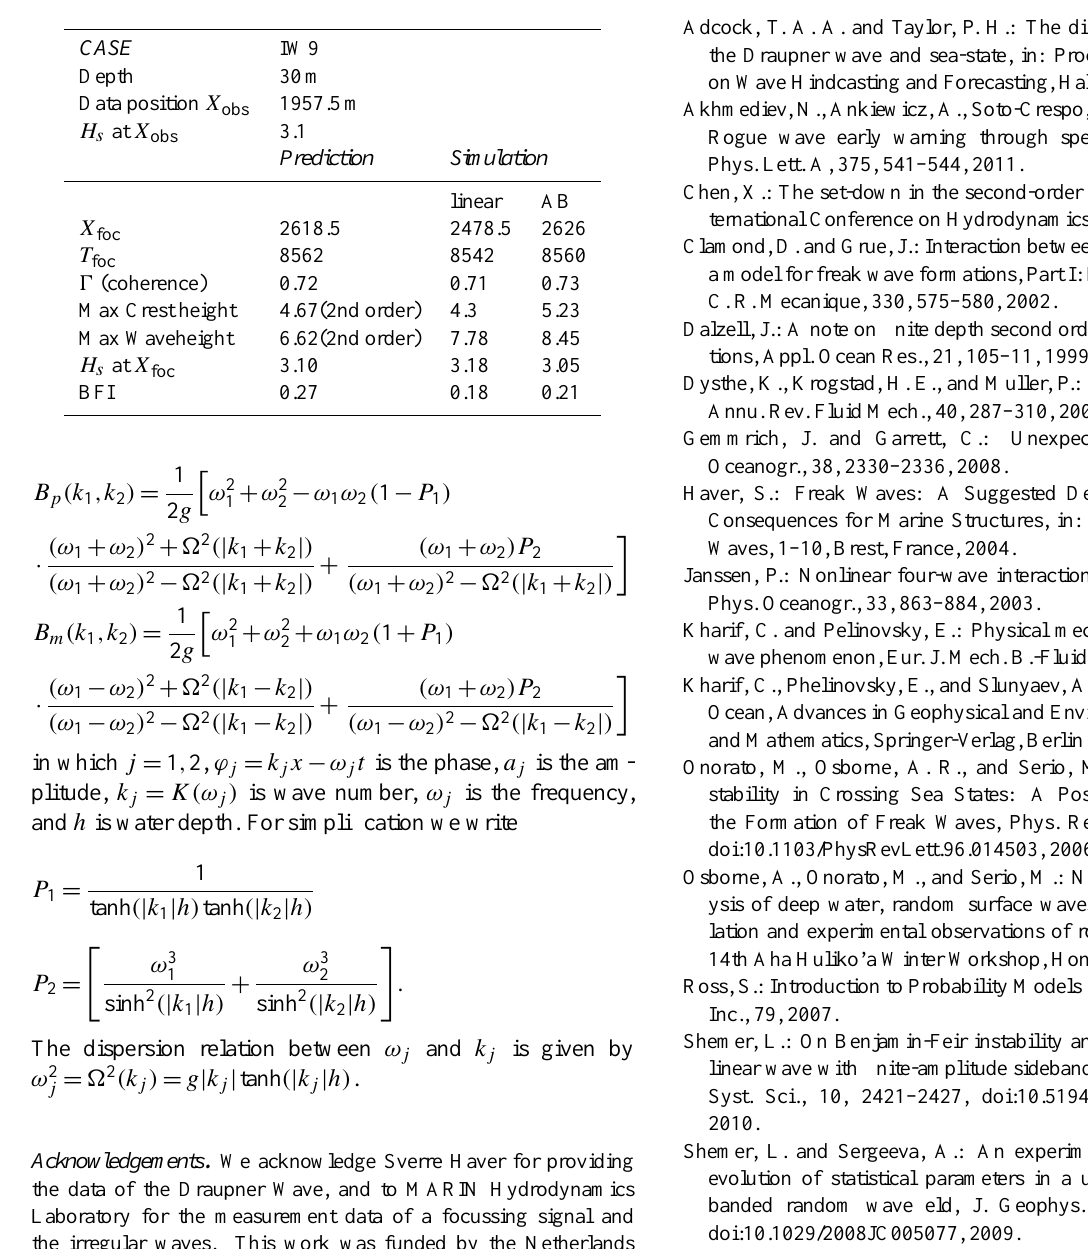
Table 4. Parameters for irregular wave